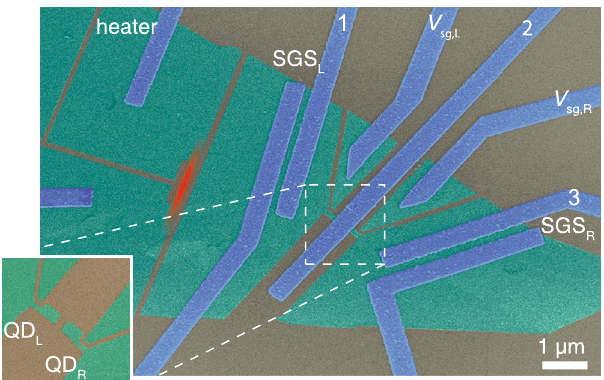
Fig. 1 False color SEM image of the device. Green indicates graphene, blue corresponds to metallic Al/Ti sandwich leads, and the silicon substrate with 280-nm-thick silicon dioxide on top is colored in gray. The Joule heated region is indicated by red color. The superconducting graphene junctions are located between the leads marked by SGS L and SGS R . The left and right graphene quantum dots QD L and QD R , respectively, have an area 200 × 150 nm 2 , foremost located under the Al injector and thus invisible in the image. Side gates with voltages V sg,L and V sg,R are also carved out of graphene. The inset at lower left corner illustrates the graphene quantum dots before overlaying the metallic Cooper pair injector. In the thermoelectric measurements, the quantum dot currents are tracked by current preampli fi ers connected to leads 1 and 3 (virtual ground 20 Ω ), while the Cooper pair injector, lead 2, is